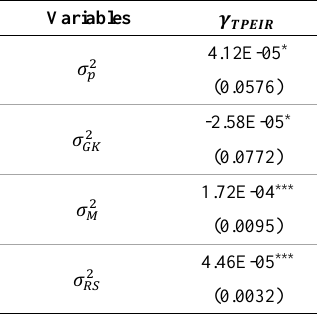
Table 5. EPU impact on TPEIR stock return